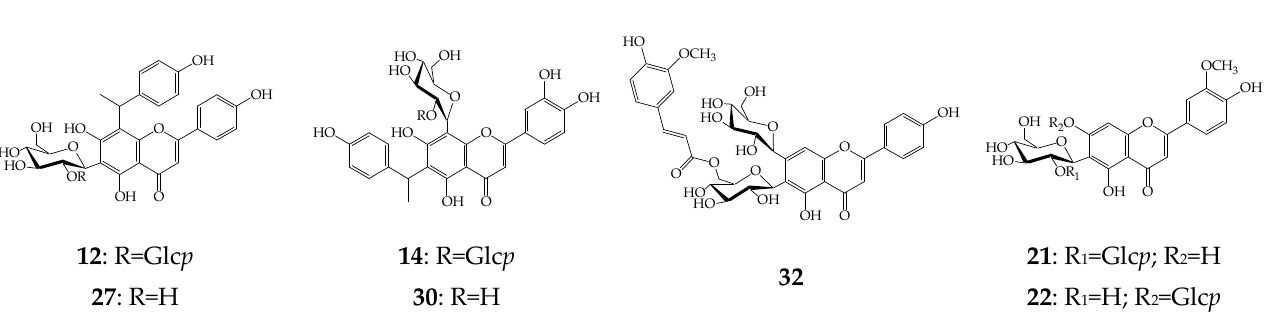
Figure 3. Known luteolin glycosides found in cucumber flowers. Glc p —glucopyranose.